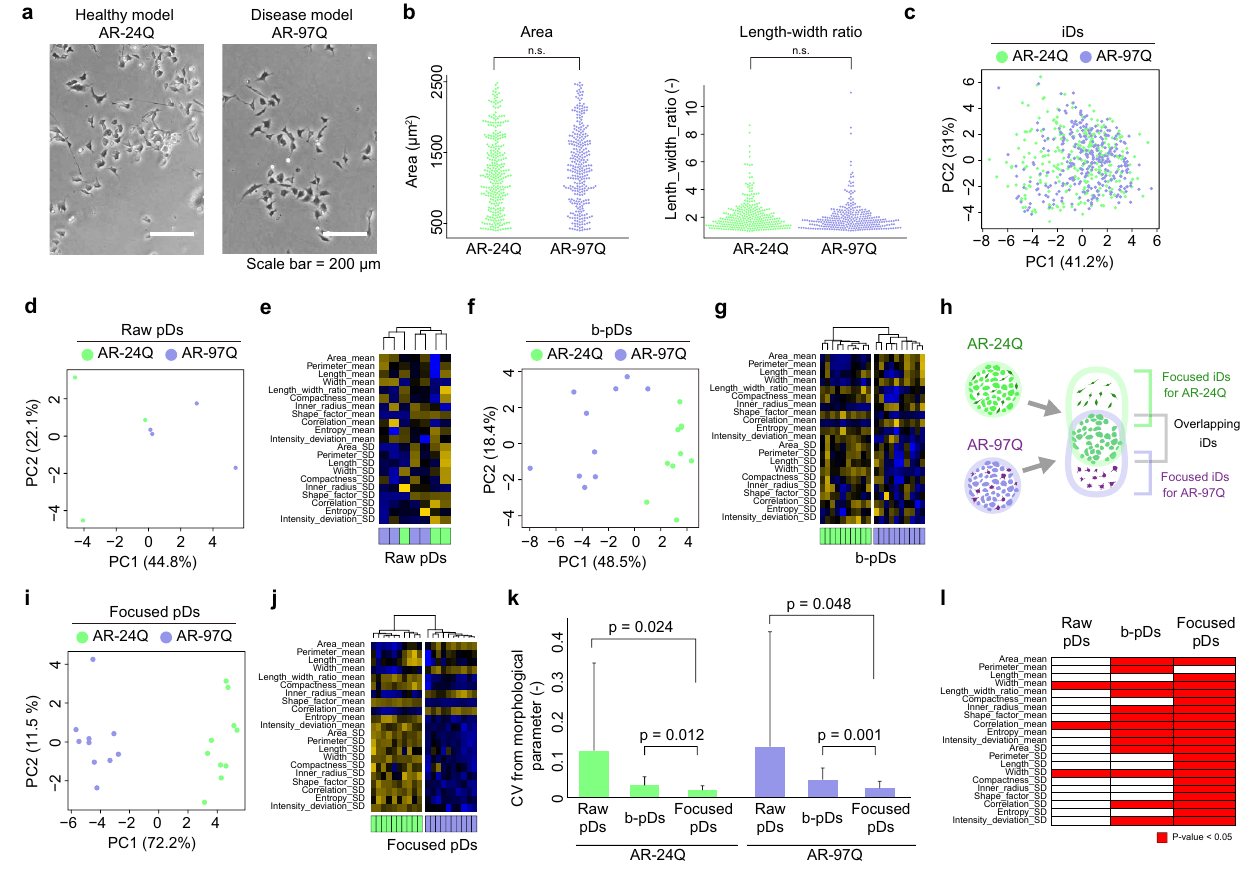
Figure 2. Evaluation of morphological heterogeneities and in silico featured-objects concentrated by anomaly discrimination from unit space (in silico FOCUS) analysis using model cells. ( a ) Representative image of model cells (healthy model, AR-24Q cells; disease model, AR-97Q cells). ( b ) Morphological distribution of 300 cells described by a single parameter. n.s. non-significant (N = 300). ( c ) Principal component analysis (PCA) of 100 cells described by 14 morphological parameters. ( d , e ) PCA and clustering of raw population data (raw pDs) (3 wells). ( f , g ) PCA and clustering of pDs with bootstrap (b-pDs) (N = 10). ( h ) Schematic illustration of in silico FOCUS applied to compare model cells. ( i , j ) PCA and clustering of pDs from in silico FOCUS (focused pDs;10 samples). ( k ) Evaluation of in silico FOCUS effect using variance of morphological parameters among pDs (Fig. S9a). p < 0.05 is indicated in the plot (N = 27). The bar plots indicate the mean of 27 coefficient of variations (CVs). Error bars indicate standard deviation. ( l ) Evaluation of in silico FOCUS effect using various morphological parameters that were significant ( p < 0.05) between AR-24Q and AR-97Q (N = 10). All illustrations created by Adobe Illustrator 24.1.1 (https:// www. adobe. com/ jp/ produ cts/ illus trator.